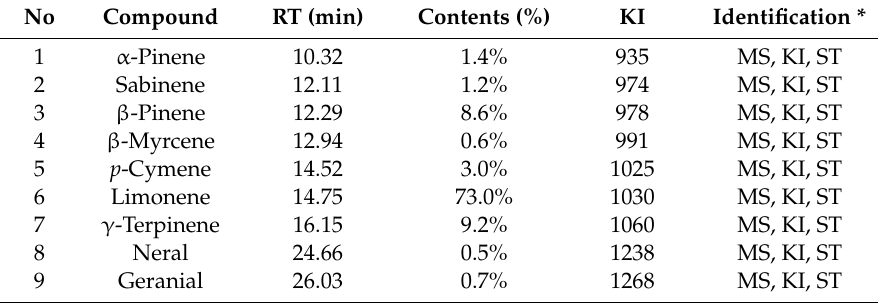
Table 3. Main components and their relative contents (%) of lemon